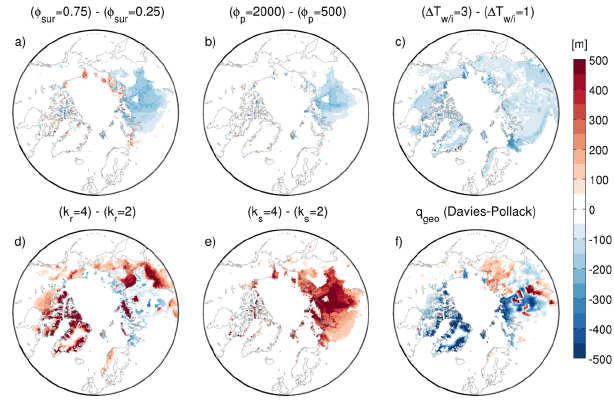
Figure 7. Sensitivity of present-day permafrost thickness to sur- face porosity (a) , exponential decay scale of porosity with depth (b) , temperature interval for ground freezing (c) , rock (d) and dry sediments (e) thermal conductivity and geothermal heat flux (f)